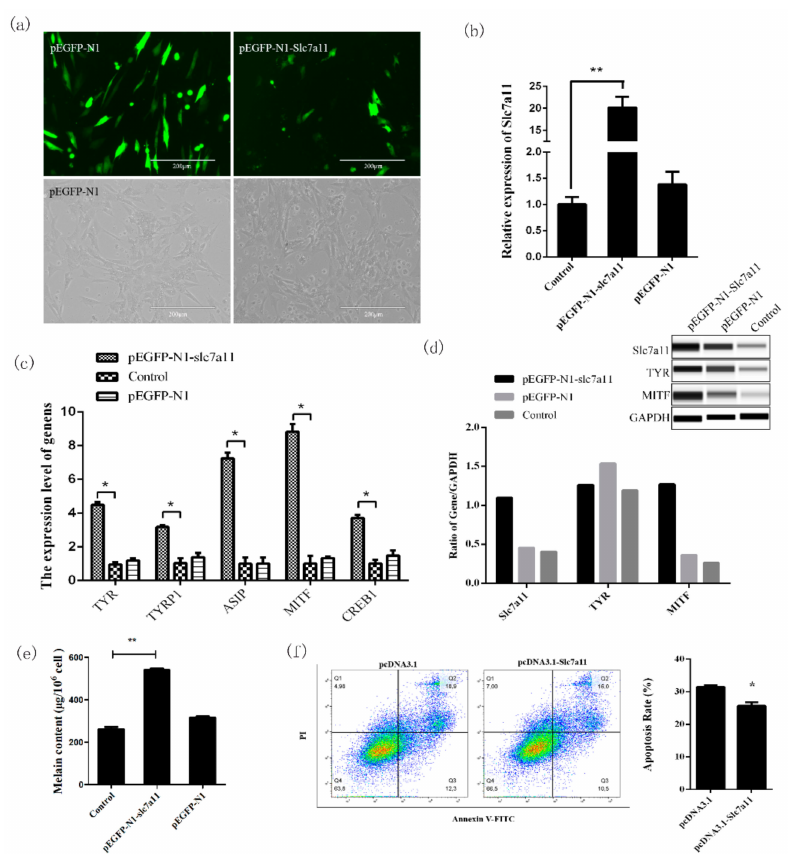
Figure 4. The expression of melanogenesis-related genes and melanogenesis were increased by the overexpression of Slc7a11 . An extremly significant di ff erence was signified with “**” ( p < 0.01), and a significant di ff erence was signified with “*” ( p < 0.05). ( a ) Fluorescence detection results of pEGFP-N1-Slc7a11 transfected melanocytes. pEGFP-N1 was used as a control. ( b ) Detection of the overexpression of Slc7a11 in melanocytes by Real-time PCR. ( c ) The e ff ect of Slc7a11 overexpression on the expression of pigmentation-related genes such as MITF , TYR , TYRP1 , CREB1 , and ASIP . ( d ) Detection of the expressions of MITF, TYR, and Slc7a11 (xCT) proteins in melanocytes by Wes. The relative expression levels of MITF, TYR, and Slc7a11 (xCT) proteins were calculated and analyzed using the Compass program. ( e ) The e ff ect of Slc7a11 overexpression on melanogenesis in melanocytes. Melanocytes were collected after siRNA-3 transfection and the melanin level was measured using a microplate reader. ( f ) Melanocyte apoptosis rate was determined after overexpression of Slc7a11